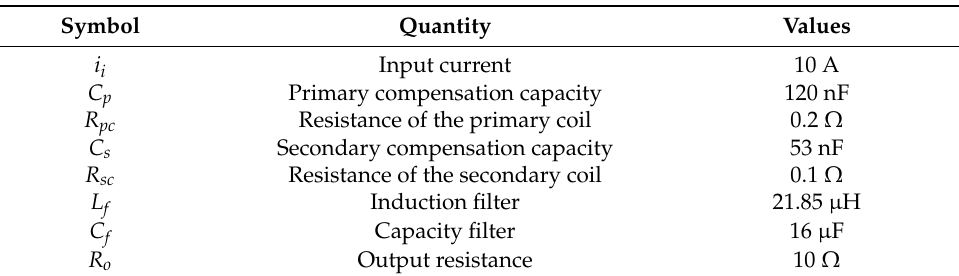
Table 5. Main circuit parameters.